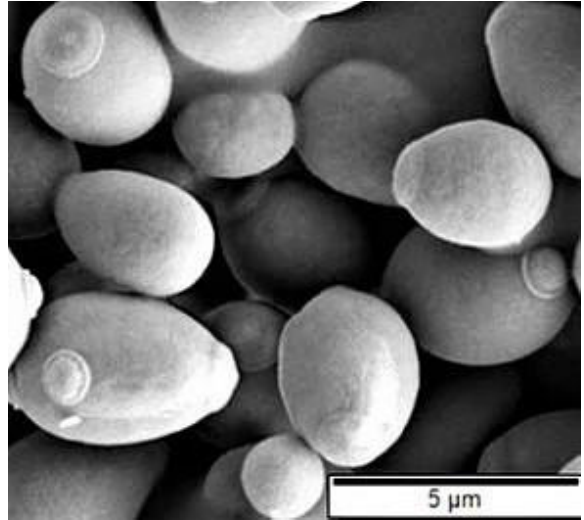
FIGURE 5: SEM image of S. cerevisiae yeast cells at the end of dry biocleaning process (18 hours) at on-site The Four Foun- tains